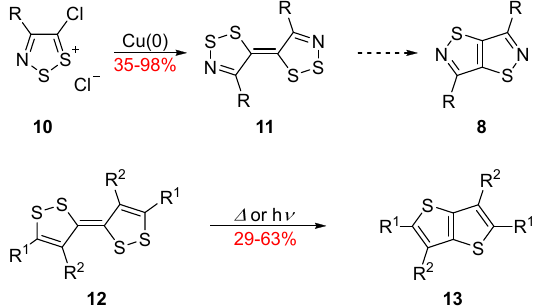
Scheme 2. Ring transformation of ( E ) ‐ 3,3 ′‐ bi(1,2 ‐ dithiolylidenes) 12 into thieno[3,2 ‐ b ]thiophenes 13